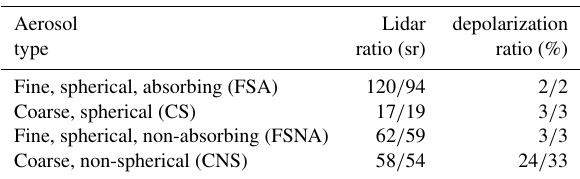
Table 1. Pre-defined aerosol components with their optical proper- ties at 355nm /